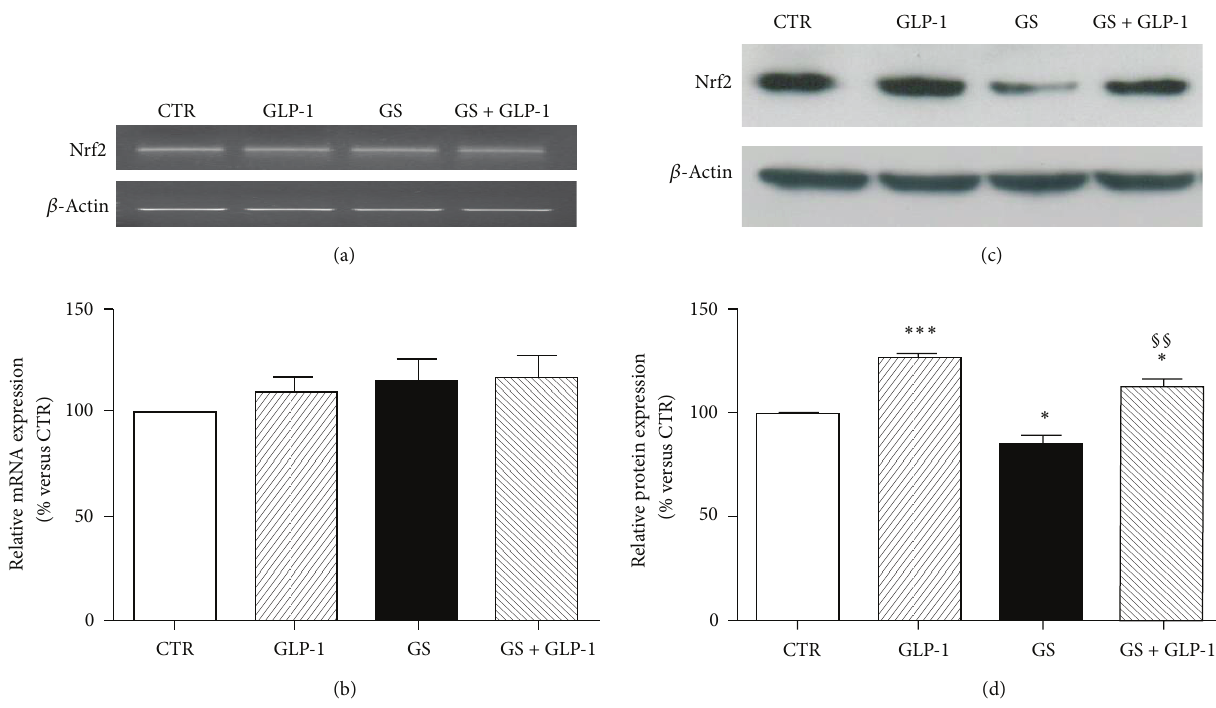
Figure 2: GLP-1 restores Nrf2 protein levels in HIT-T15 cells cultured in the presence of GS. (a)-(b) Semiquantitative RT-PCR of Nrf2 mRNA expression in HIT-T15 cells cultured 5 days in standard medium (CTR) or in medium containing AGEs (GS) in the presence or absence of 10nmol/L GLP-1. (a) Representative agarose gel of three different experiments. (b) Quantification of densitometries of agarose gel bands. Data were represented as mean ± SE of percentage change from CTR level (100%) ( 𝑛 = 3 ). (c)-(d) Western blot analysis of Nrf2 protein intracellular expression in HIT-T15 cells cultured in the same conditions as mRNA experiments. (c) Representative western blot of three different experiments. (d) Quantification of densitometries of western blot bands. Data were expressed as mean ± SE of fold induction relative to 𝛽 -actin ( 𝑛 = 3 ). ∗ 𝑃 < 0.05 versus CTR; ∗∗∗ 𝑃 < 0.001 versus CTR; §§ 𝑃 < 0.01 versus